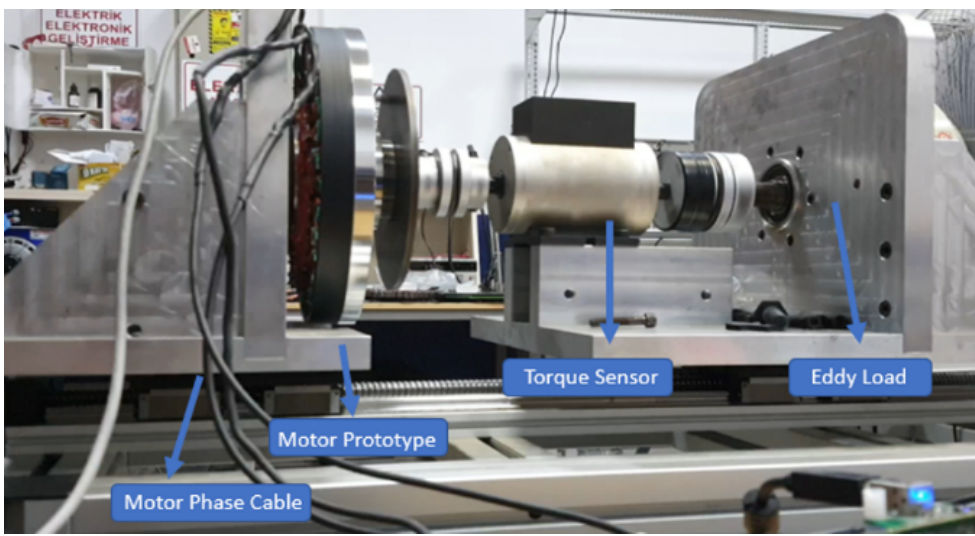
Figure 23. At-load testing of the motor on the test